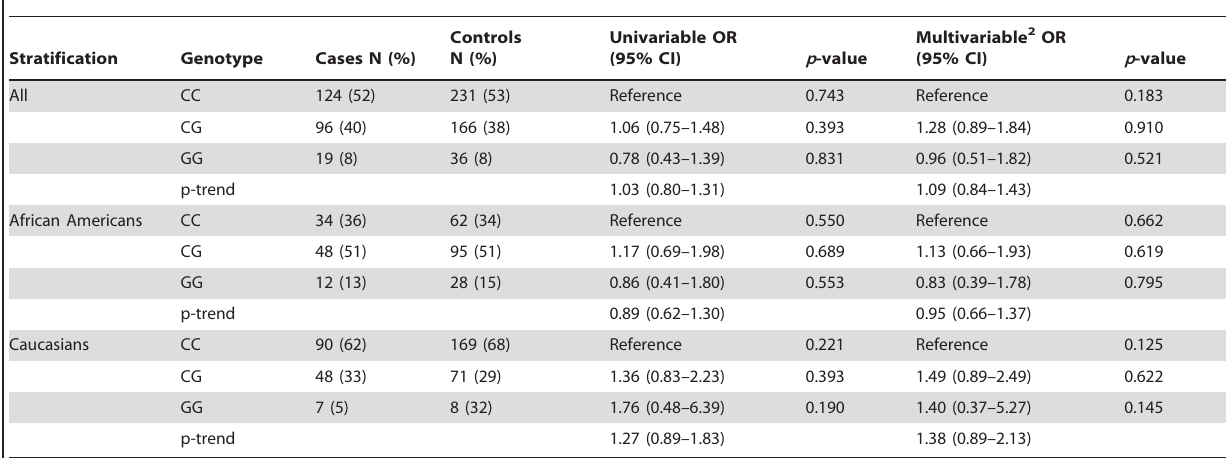
Table 2. Association of rs4919510, a SNP in mir-608 , with colorectal cancer risk.